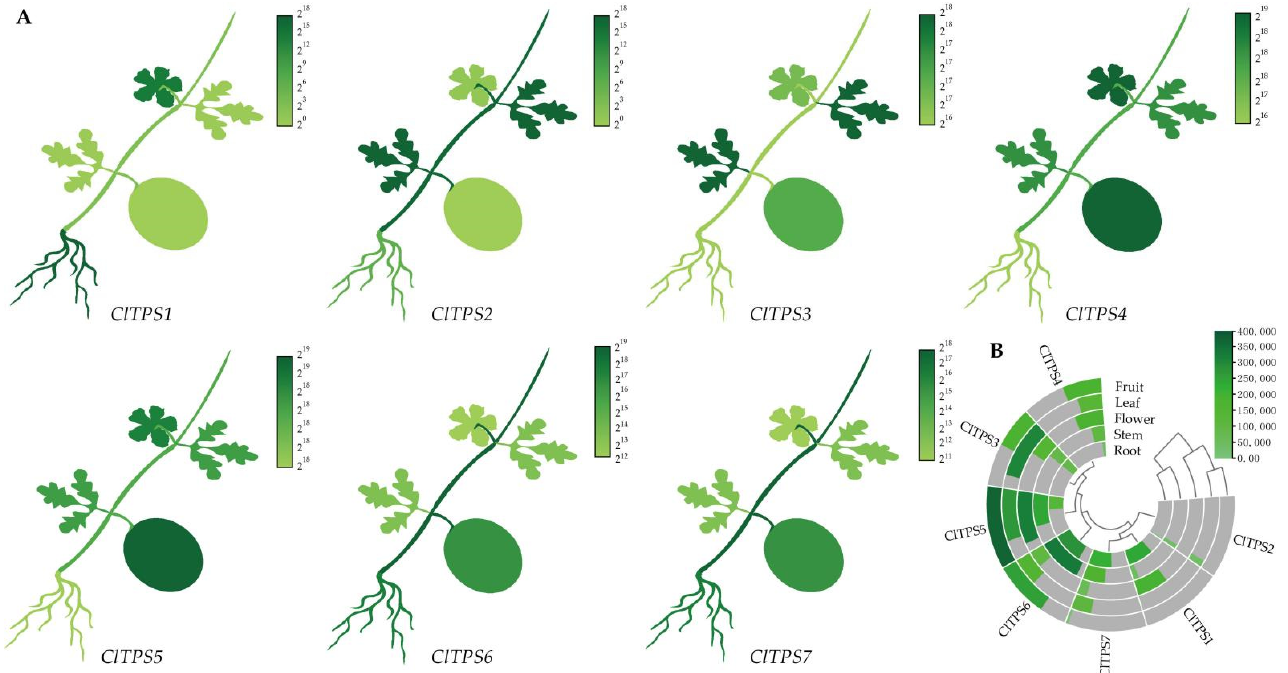
Figure 5. Tissue-specific expression of ClTPSs. ( A ) The heatmap shown in the form of the whole plant. ( B ) The heatmap and cluster analysis of tissue-specific expression. The expression levels were derived from NCBI and visualized by TBtools; the dark green represents high expression level, and the light green represents low expression level.